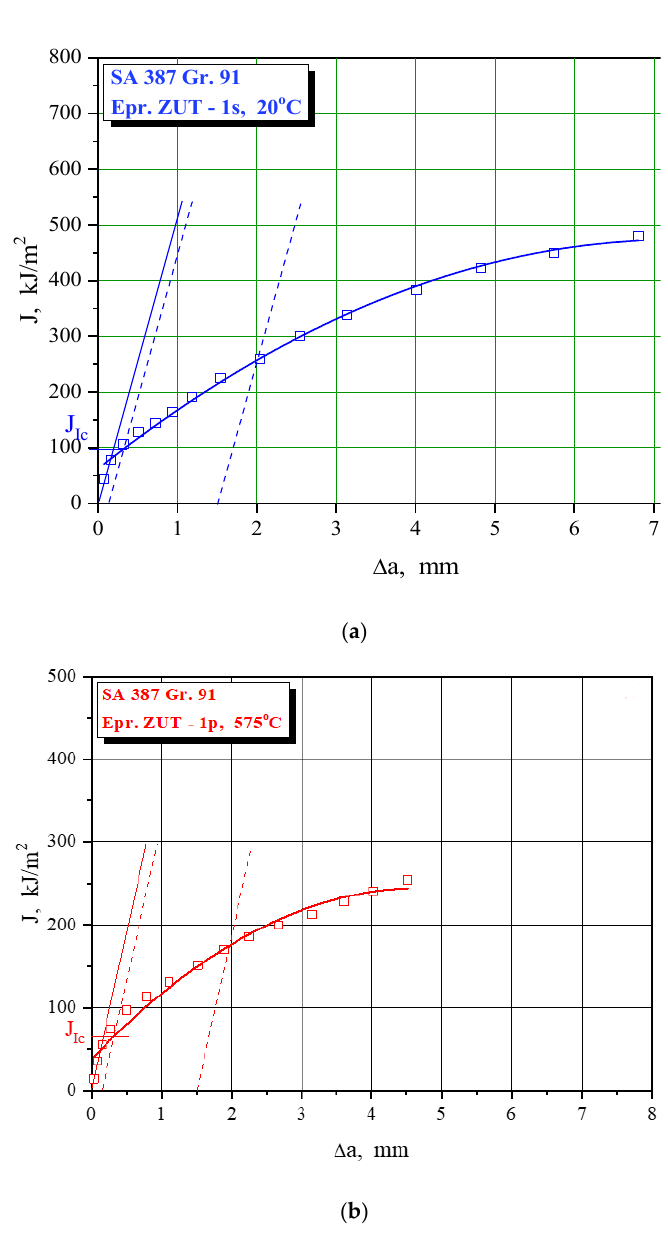
Figure 13. The J ‐ R curve and J Ic evaluation for SA 387 Gr. 91—HAZ at ( a ) 20 °C, ( b ) 575 °C. Figure 13. The J-R curve and J Ic evaluation for SA 387 Gr. 91—HAZ at ( a ) 20 ◦ C, ( b ) 575 ◦ C. Table 10. K Ic values obtained via J Ic for SA 387 Gr. 91—BM. Table 11. K Ic values obtained via J Ic for SA 387 Gr.